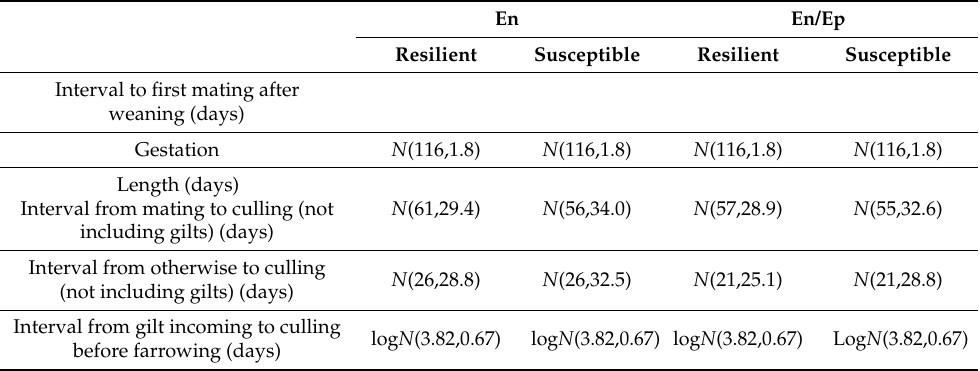
Figure 2. Overview showing ( a ) the model sheet with the main blocks: Input parameters, Manage- ment, Piglets, and Farm, besides two standard blocks for plotting and statistics reporting. ( b ) Nested windows illustrate the hierarchy structure of the Farm block ( b 1 ) housing 1500 individual sows grouped into blocks of one hundred ( b 2 ) individual sows ( b 3 ) and ( c ) the library containing the specific blocks of this model.